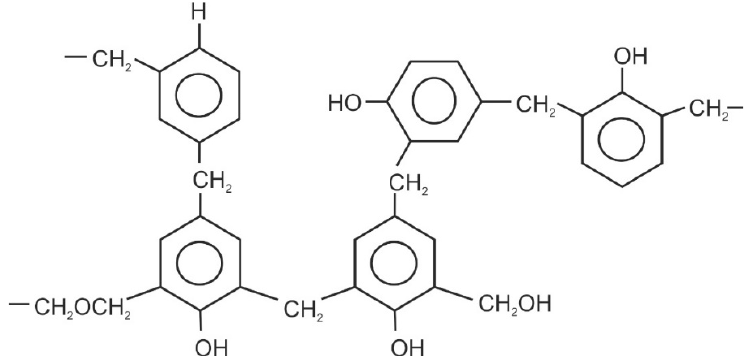
Figure 16. Chemical structure of novoloid resin which built up Kynol fibers. Table 3. Comparison of properties of some flame-retardant